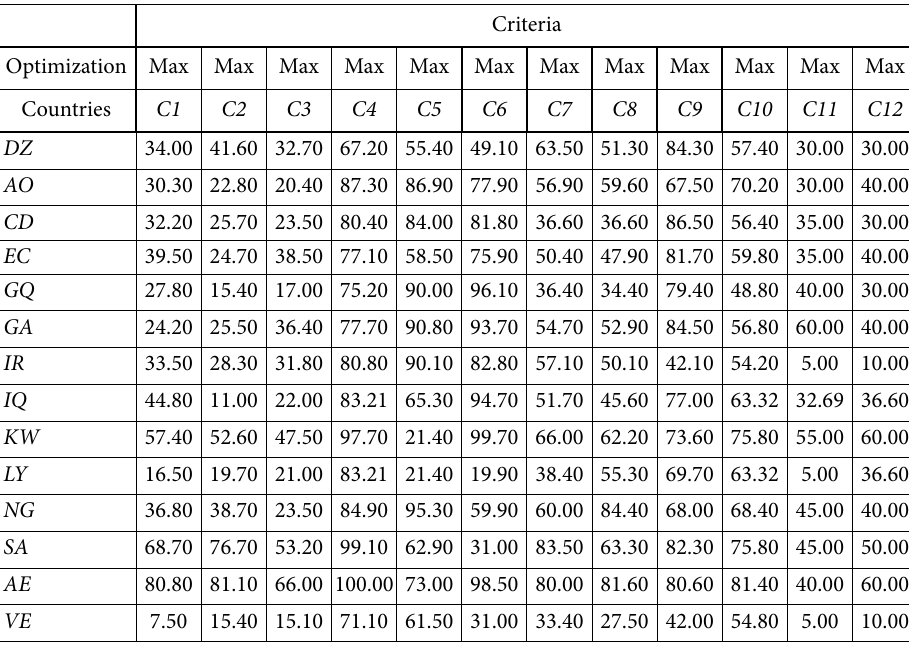
Table 1. Economic freedom indicators of OPEC countries by 2021 (source: Miller et al., 2021)